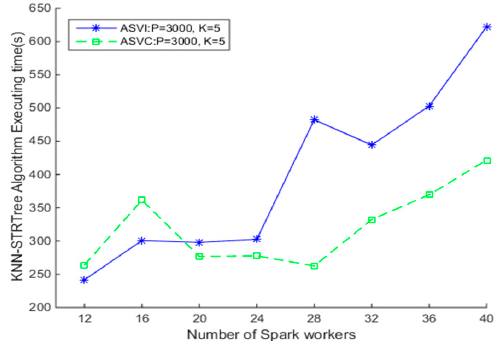
Figure 7. Comparison of Spark-based K Nearest Neighbor Sort-Tile-Recursive tree (KNN-STRtree) algorithms using ASVI and ASVC strategies.